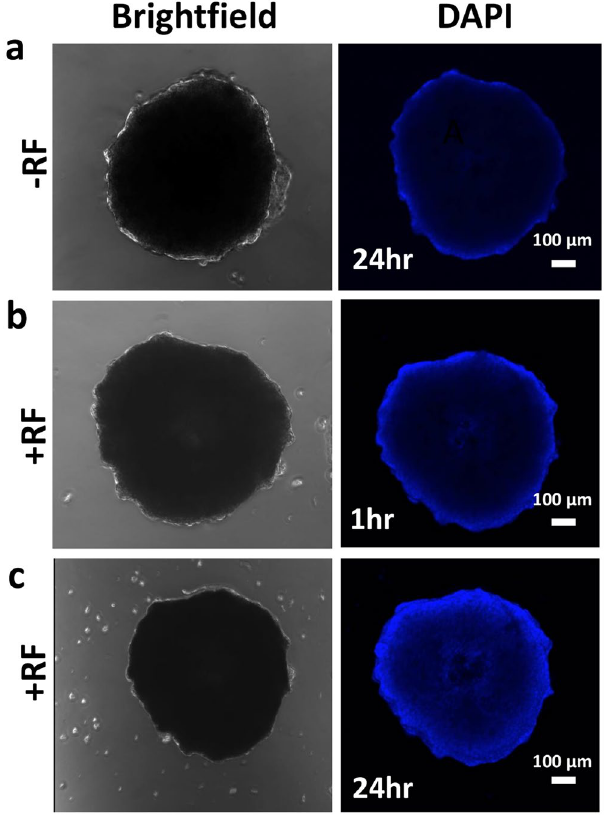
Figure 2. Exposure to non-invasive RF field increases diffusive penetration of molecules in 3D tissue. Left: Brightfield image of untreated Capan-1 spheroid; right: DAPI wavelength image. ( a ) Spheroid untreated with RF and incubated with DAPI for 24 h; ( b ) Spheroid treated with RF and incubated with DAPI for 1 h; ( c ) Spheroid treated with RF and incubated with DAPI for 24 h. Spheroid in ( b ) and ( c ) is the same lesion. Magnification: